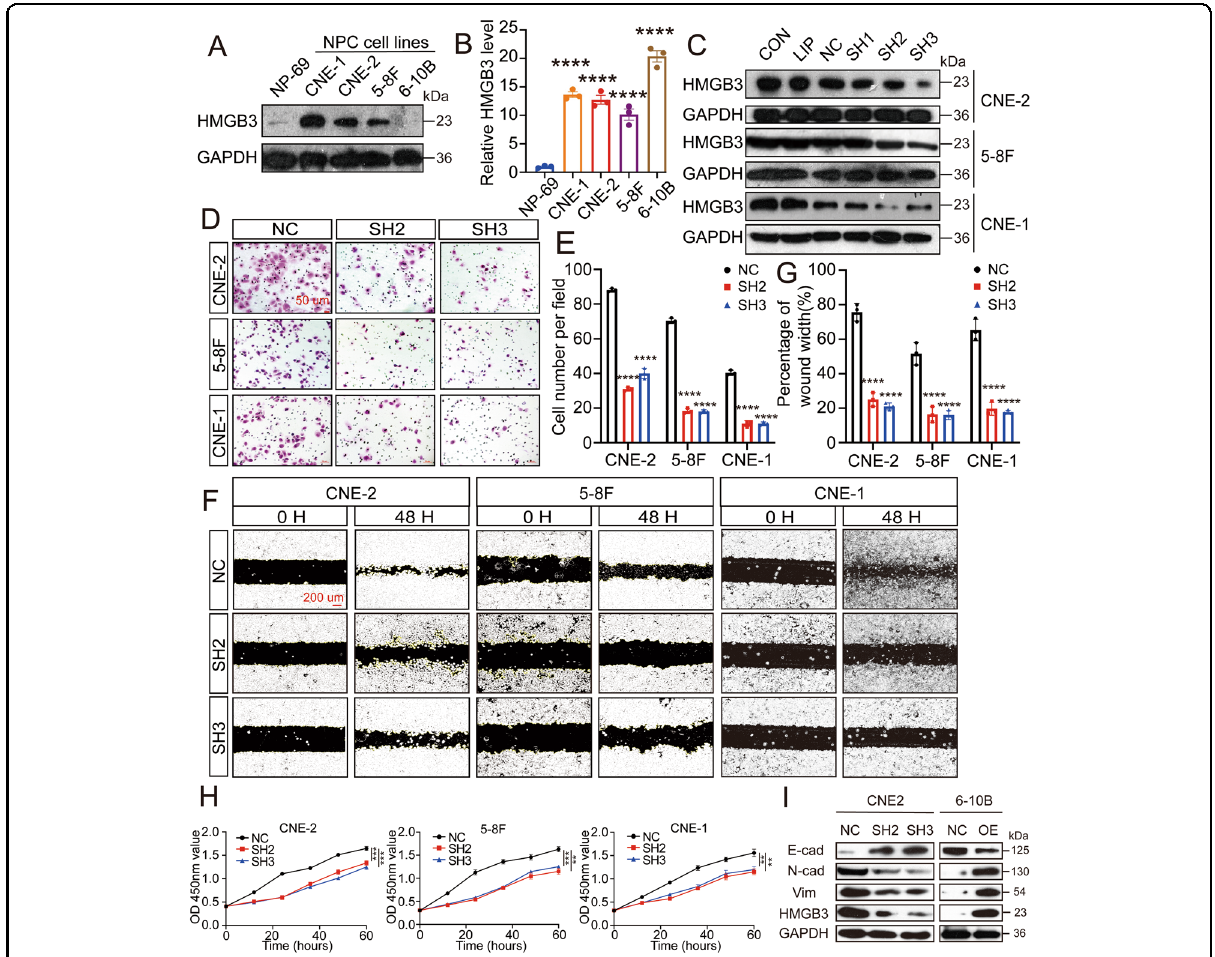
Fig. 3 HMGB3 knockdown reduces NPC cell proliferation and migration in vitro. A HMGB3 protein levels in NP69 and NPC cell lines (CNE1, CNE2, 5 – 8 F and 6 – 10B) were determined by western blot. B HMGB3 mRNA levels in NP69 and NPC cell lines were examined by qRT-PCR (one-way ANOVA). C Transfection ef fi ciency of three NPC lines (CNE1, CNE2 and 5 – 8 F) was measured by western blot. CON control, LIP lip2000, NC negative control, SH1 shHMGB3-1, SH2 shHMGB3-2, SH3 shHMGB3-3. D The transwell assay was performed to measure cell migration. The scale bar represents 50 µm. E Statistical comparison of the cell number of the transwell assay in the two groups. F The wound closure assay was performed to measure cell migration. The scale bar represents 200 µm. G Statistical comparison of the percentage of wound width in the two groups. H The CCK8 assays were performed to measure cell proliferation. All experiments were conducted with three independent replicates. I The levels of HMGB3 and EMT markers in NPC cell lines after knockdown or overexpression of HMGB3 were determined by western blotting. GAPDH expression was used as a loading control. Mean ± SD, ** P < 0.01, *** P < 0.001,**** P < 0.0001, student ’ s